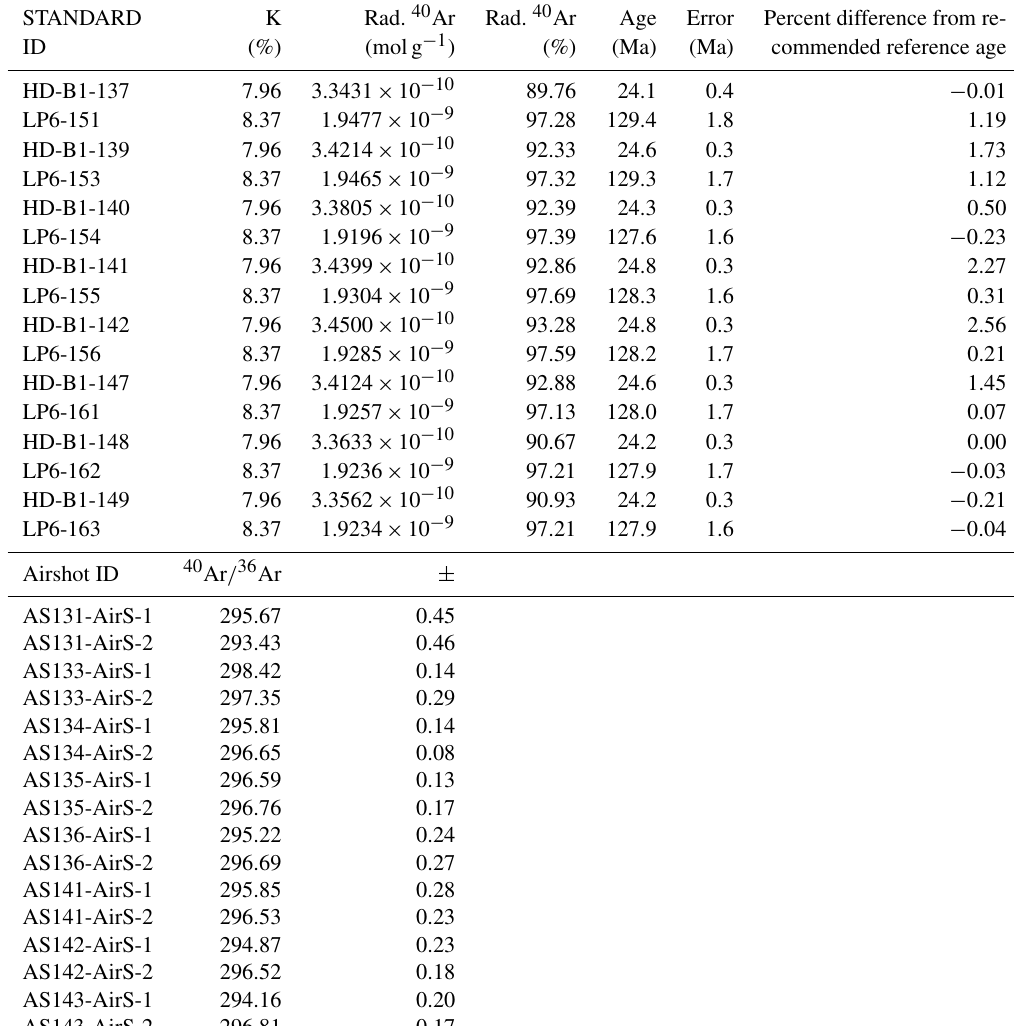
Table 2. K–Ar standard and airshot